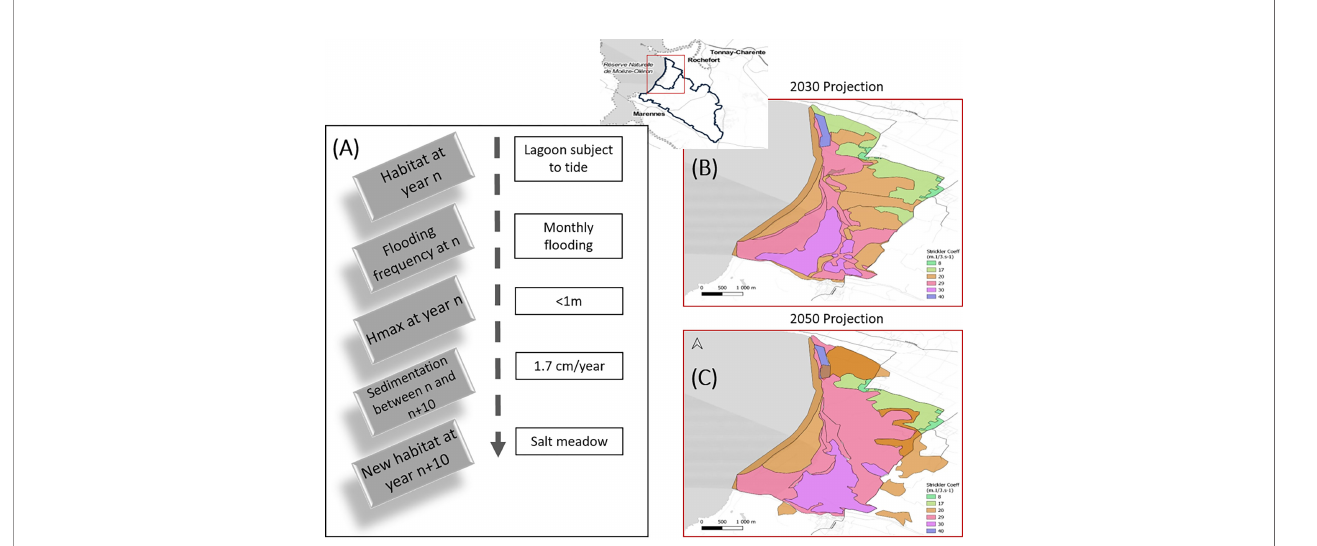
FIGURE 5 | Land-use projections: (A) method for assigning new habitats (grey boxes), and example (white boxes), adapted from Fouin et al. (2020); (B) translated into Strickler coef fi cients by 2030; (C) translated into Strickler coef fi cients by